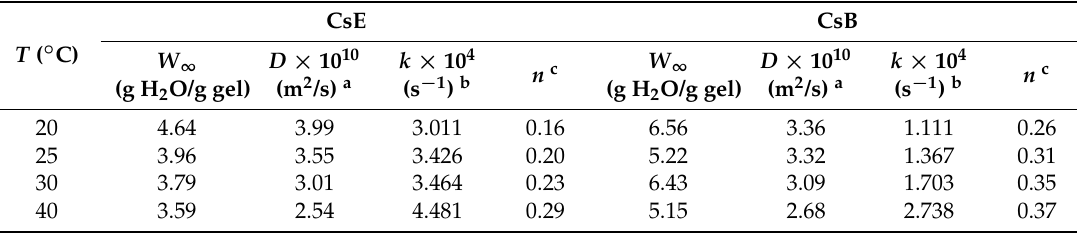
Table 3. Values of the degree of swelling, diffusion coefficient, second-order kinetic constant and the release exponent of CsE and CsB aerogels of swelled in water at different